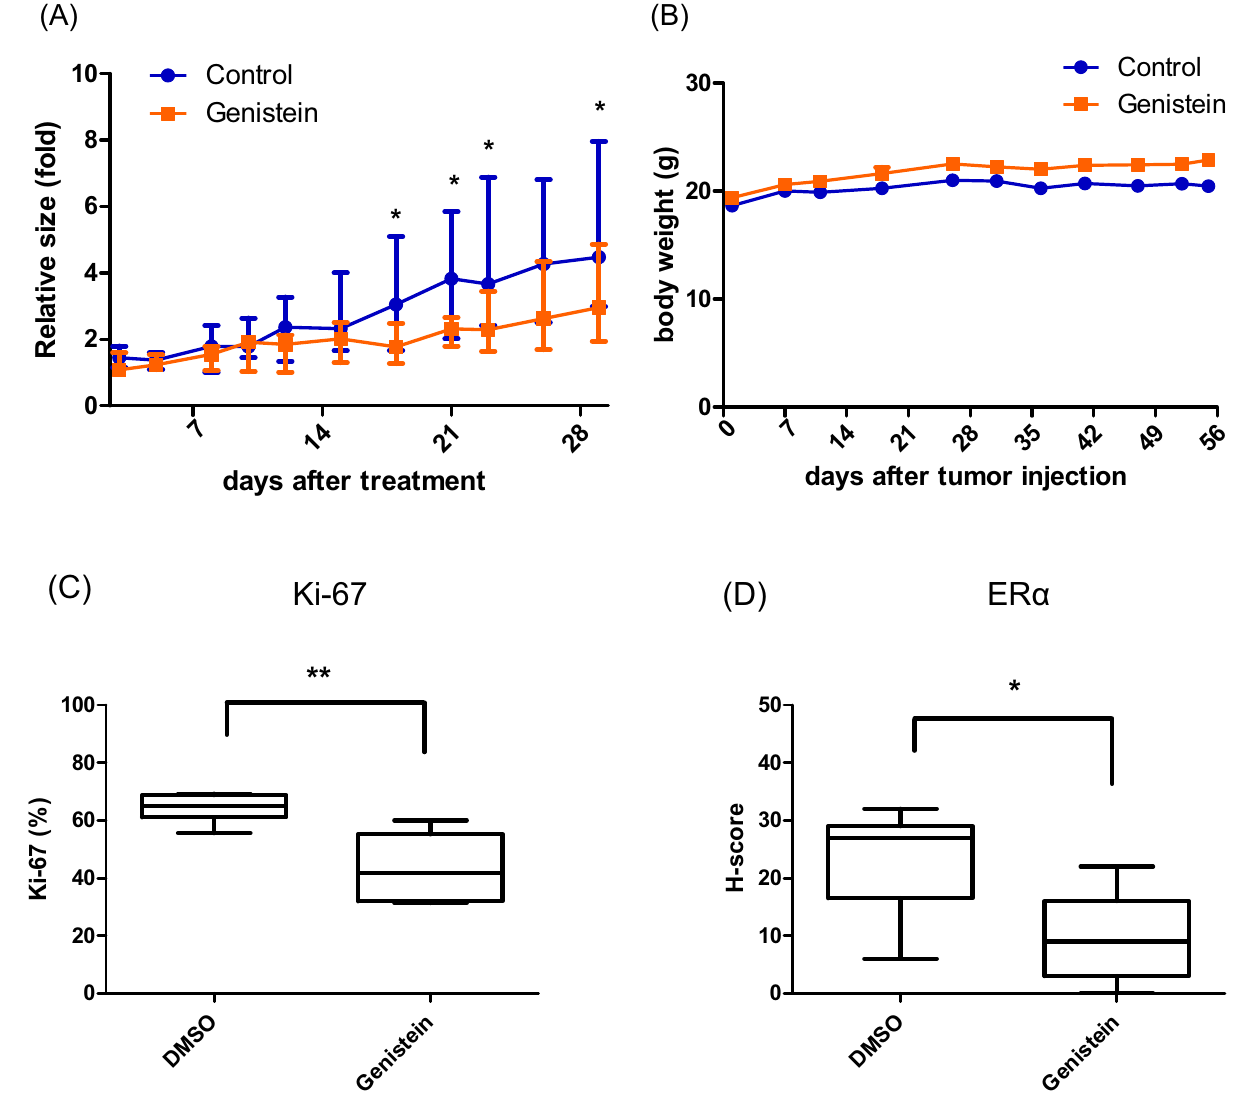
Figure 5. Effects of genistein on in vivo endometrial cancer cell growth using a mouse xenograft model. To analyze in vivo tumor growth, xenograft model mice inoculated with Ishikawa cells were treated by intraperitoneal injection of vehicle or genistein (90 mg/kg body weight) on alternate days for four weeks. Tumor volume in genistein and control groups during experiments (complete data shown in Supplementary Table 1) ( A ). Proliferation rate calculated on the basis of Ki-67-immunopositive cells in tumor sections ( C ). Body weight of the genistein and control groups ( B ). Estrogen receptor alpha (ERα) levels were immunohistochemically evaluated by H-score ( D ). Data represent the mean ± standard error of the mean (n = 6). P values are based on Student’s t -test. * P < 0.05; ** P <